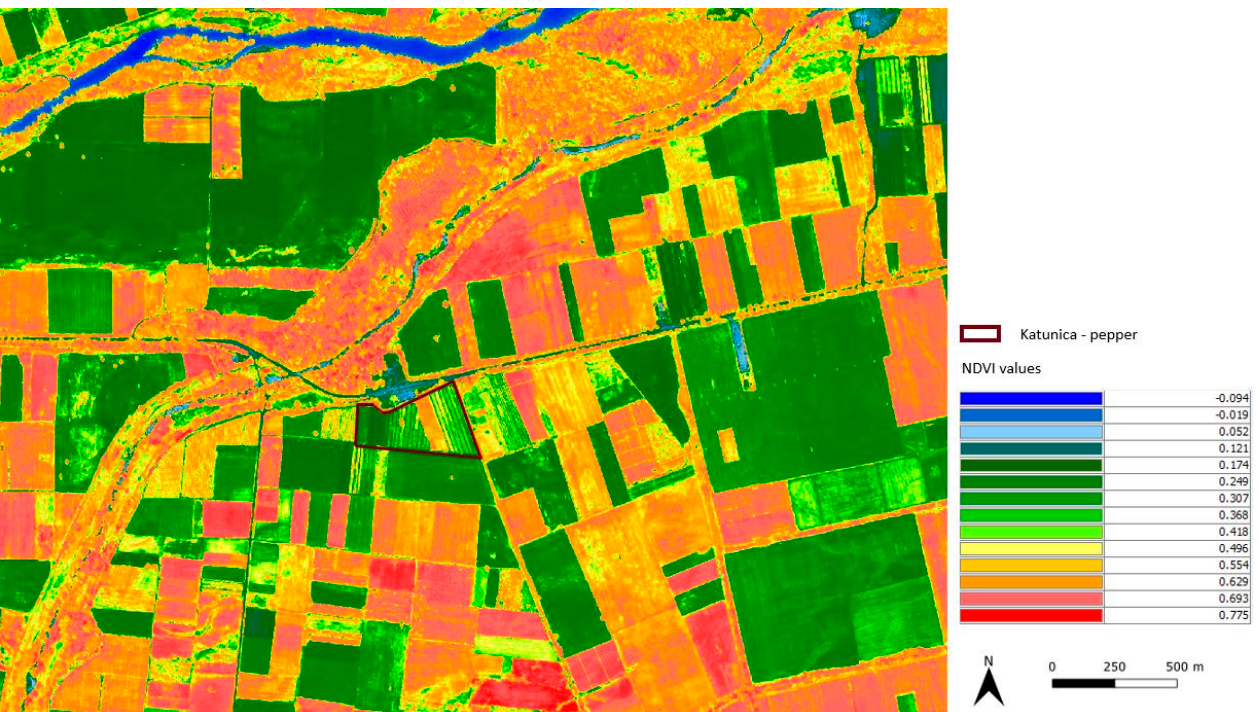
Figure A1. NDVI for Katunica, Bulgaria pepper field retrieved from WorldView-3 satellite image, GSP 1.24 m.